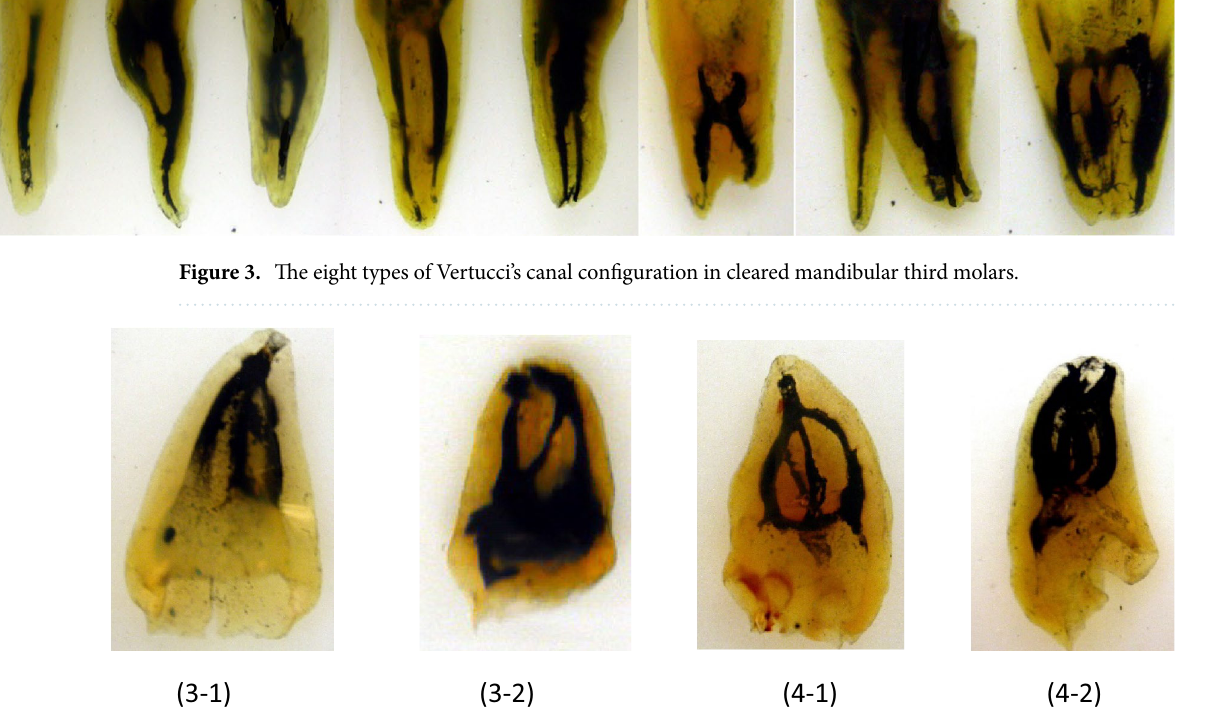
Figure 4. Cleared maxillary third molars with additional canal configurations.